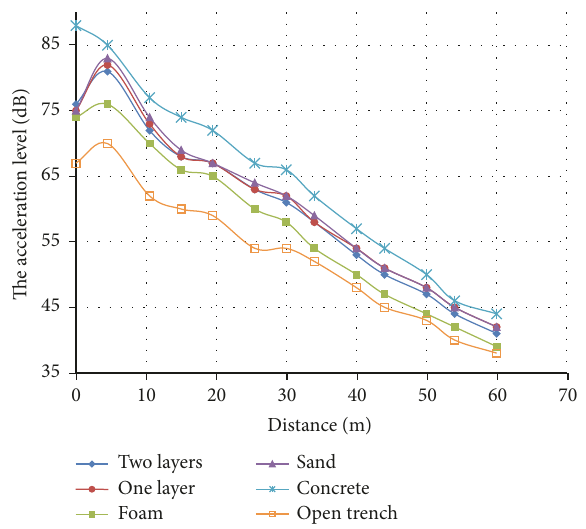
Figure 8: The relationship between the acceleration level and distance under case 3 .